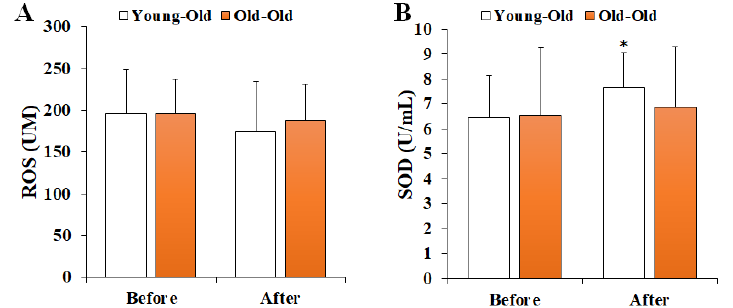
Figure 1. Changes in serum oxidant–antioxidant markers. Values presented by mean and standard deviation. ( A ) ROS, reactive oxygen species; ( B ) SOD, superoxide dismutase; * Significantly different versus Before ( p < 0.05).